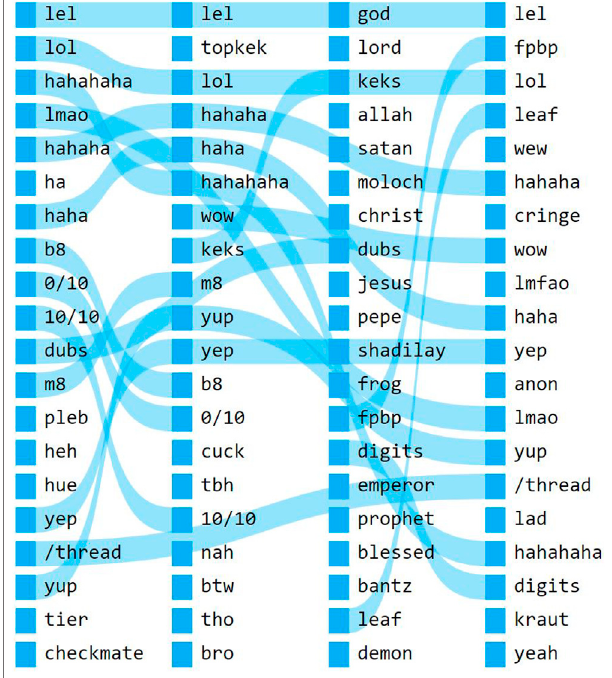
FIGURE3| Rank fl owdiagramof kek inour4chandataset.Similarwords are sorted vertically, from most similar to least similar. Each vertical stack represents a single snapshot, respectively 2012-2014, 2014-2016, 2016- 2018, and